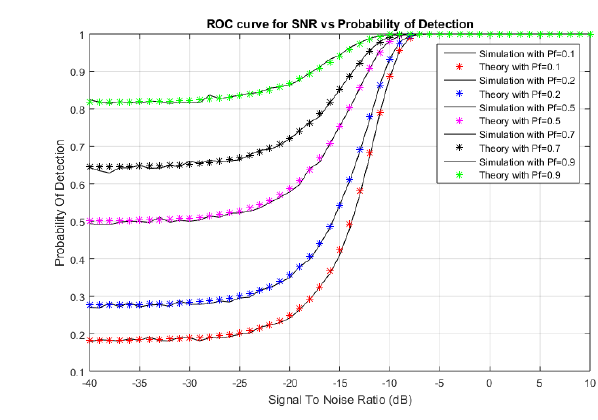
As from the above Figure 4 it is evident that when the energy detector is being used in such conditions that the SNR values are varied from -30 - 10 dB the Rayleigh fad- ing channel e ffi ciency gets decreased accordingly. This shows that the probability detection values get increased when the signal to noise ratio increases.